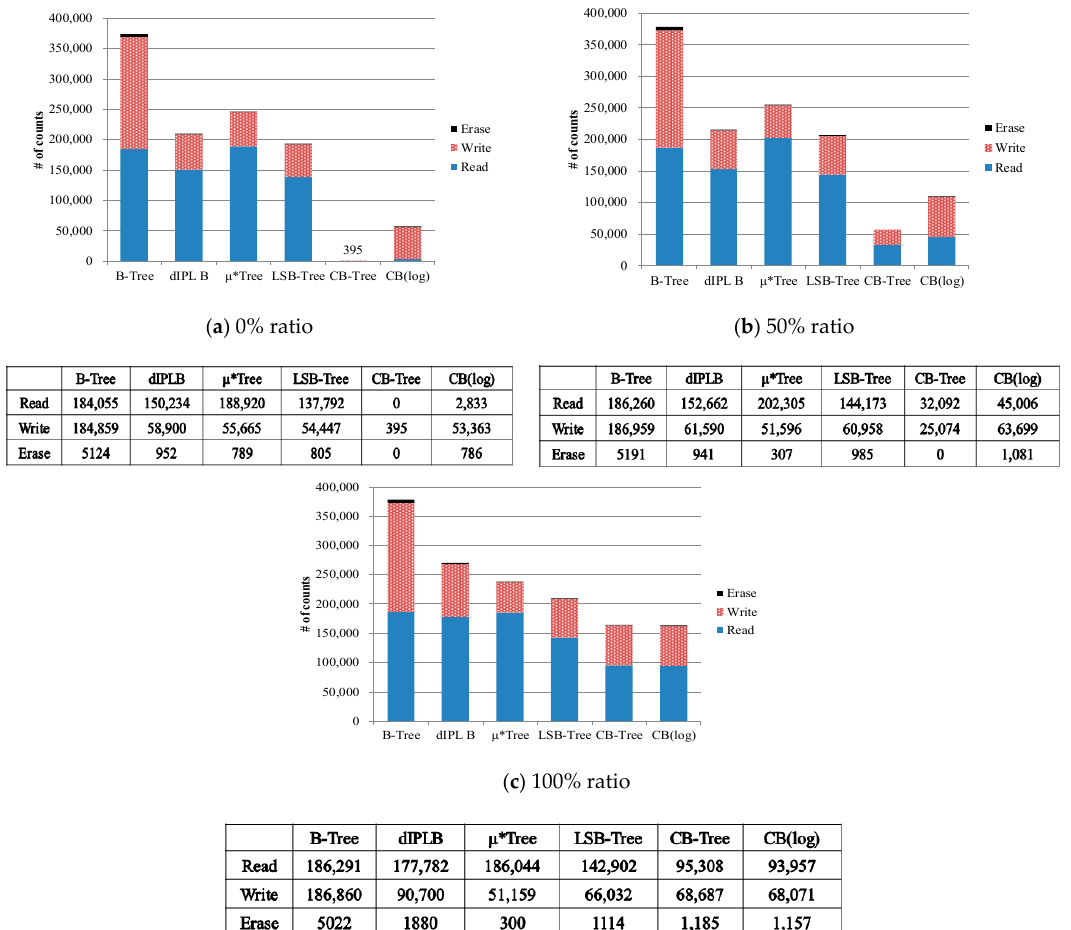
Figure 16. The number of flash operations in Structure-modified B-Trees.